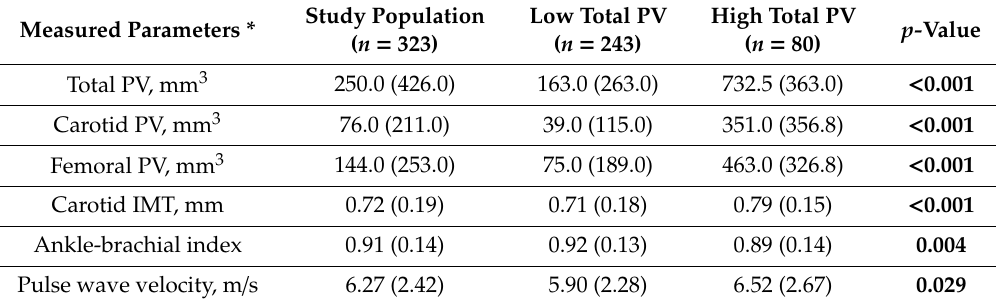
Table 2. Measured